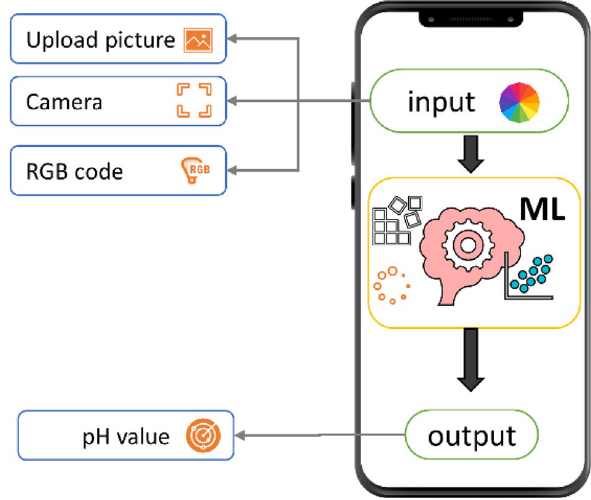
Figure 7. Schematic process of pH detection using ML.